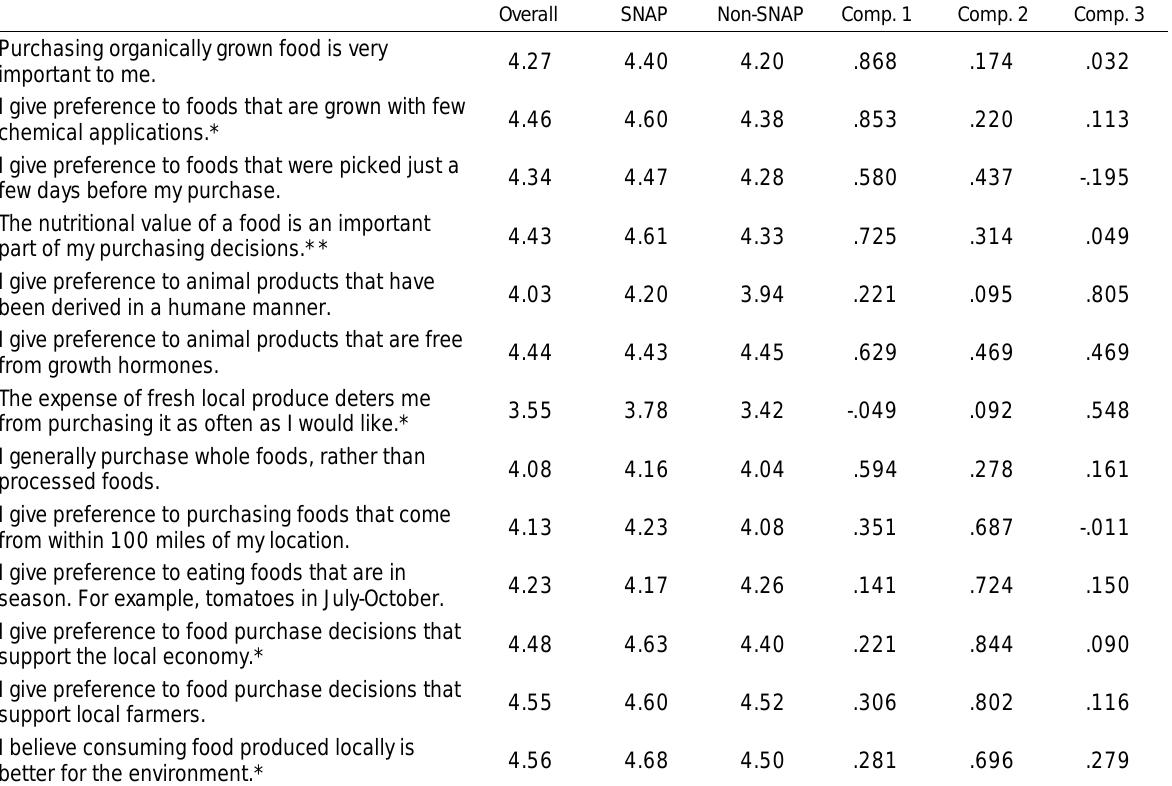
Table 3. Local Food Motive-Values from Survey Question 17 (1=strongly disagree through 5=strongly agree)